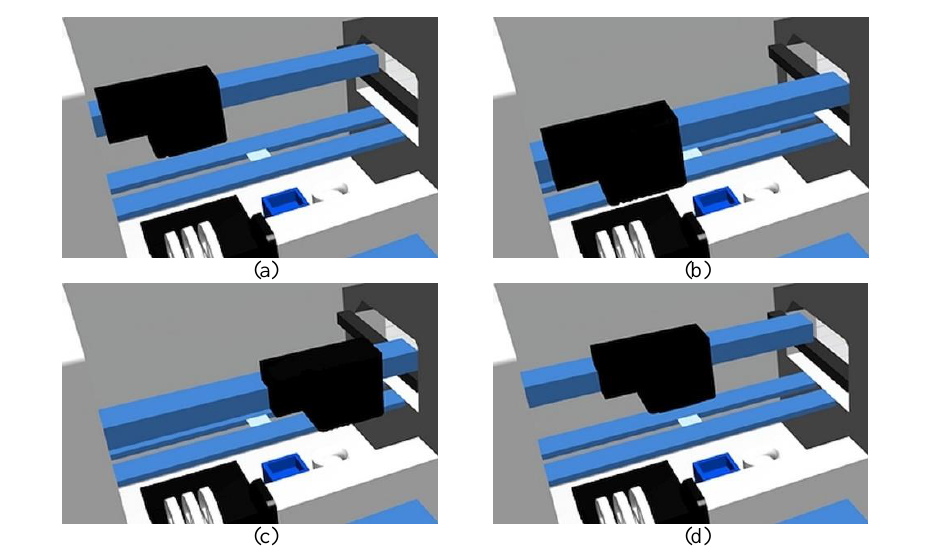
Fig. 5. The positions of the individual units of the component pick and place machine when setting up its kinematics: a) the initial position of the block of assembly heads; b) the movement of the block of heads along feeders with picking up components; c) carrying picked up components over the on-the- fly cameras of the vision system; d) stop at the component placement